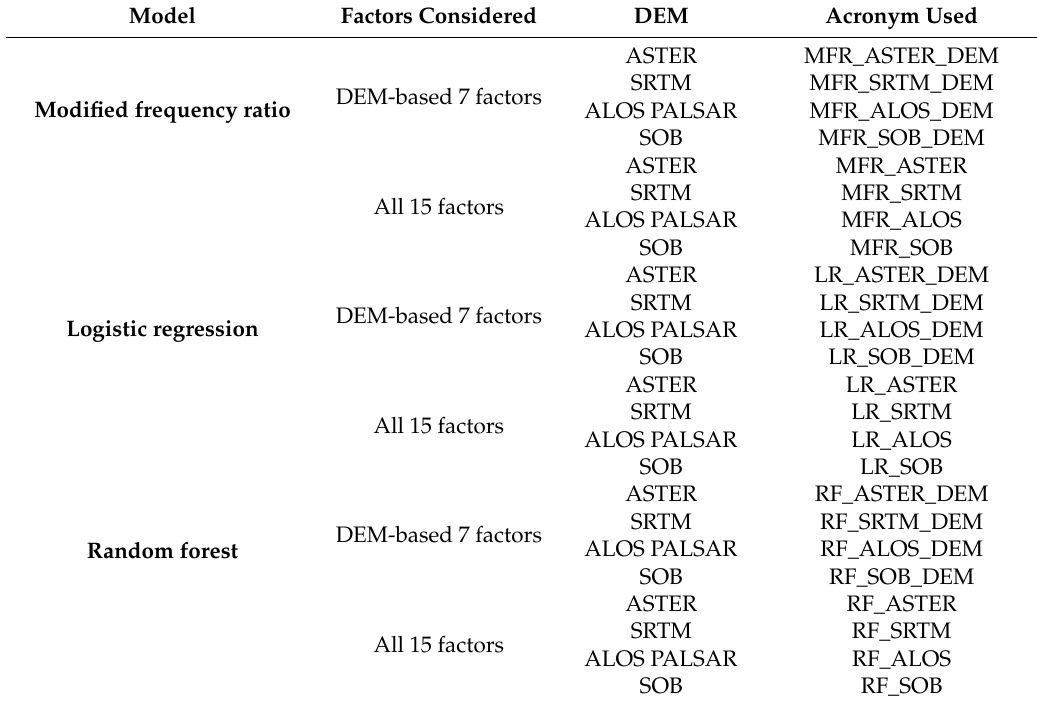
Table 2. Acronyms used for di ff erent